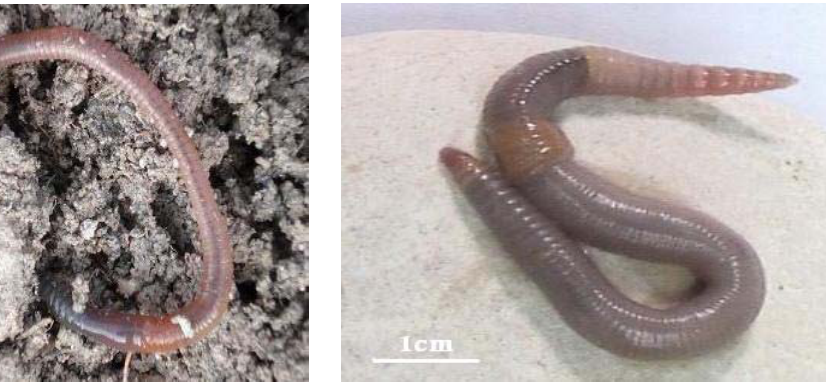
F IGURE 8. Eiseniella tetraedra. F IGURE 9. Octolasion